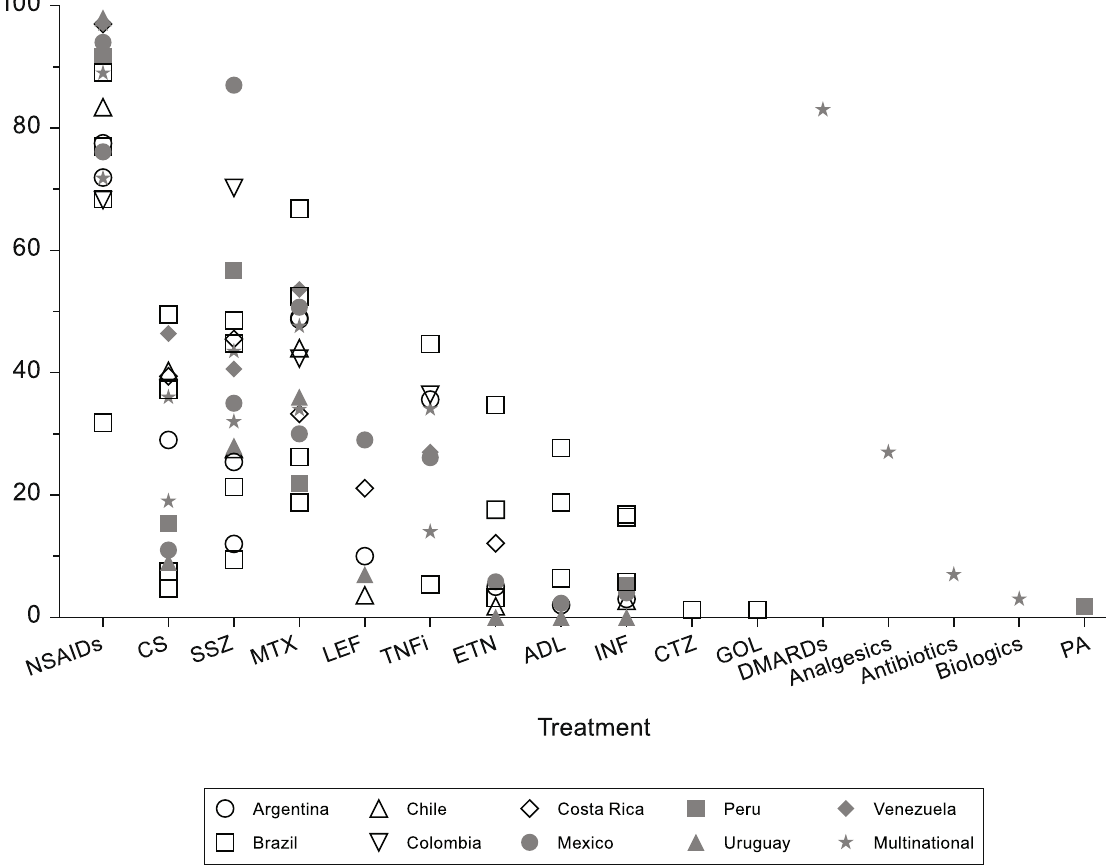
Fig. 2 Treatments utilized by Latin American patients with SpA. Source data for this figure can be found in Supplementary Table 3. ADL, adalimumab; CS, corticosteroids; CTZ, certolizumab pegol; DMARDs; disease-modifying anti-rheumatic drugs; ETN; etanercept; EU, European Union; GOL, golimumab; INF, infliximab; LEF, leflunomide; MTX, methotrexate; NSAIDs, non-steroidal anti-inflammatory drugs; PA, pamidronic acid; SSZ, sulfasalazine; TNFi, tumor necrosis factor